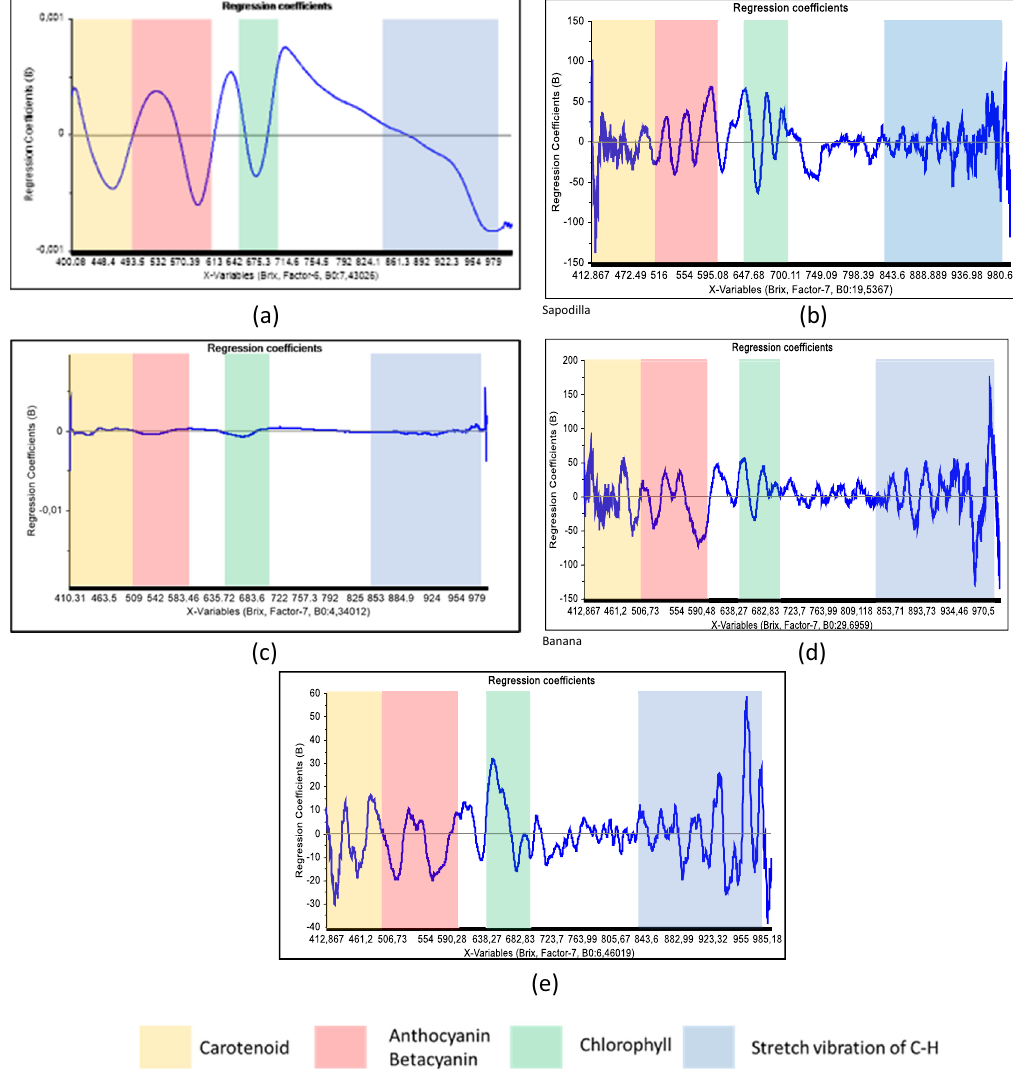
Figure 3: Regression coe ffi cient from the best PLSR model for ( a ) dragon fruit, ( b ) sapodilla, ( c ) tomato, ( d ) banana, and ( e )